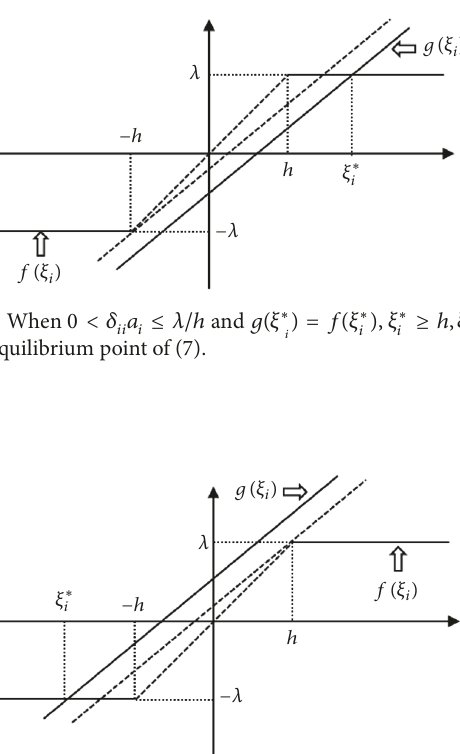
Figure 6: When 0 < 𝛿 𝑖𝑖 𝑎 𝑖 ≤ 𝜆/ℎ and 𝑔(𝜉 ∗ negative equilibrium point of